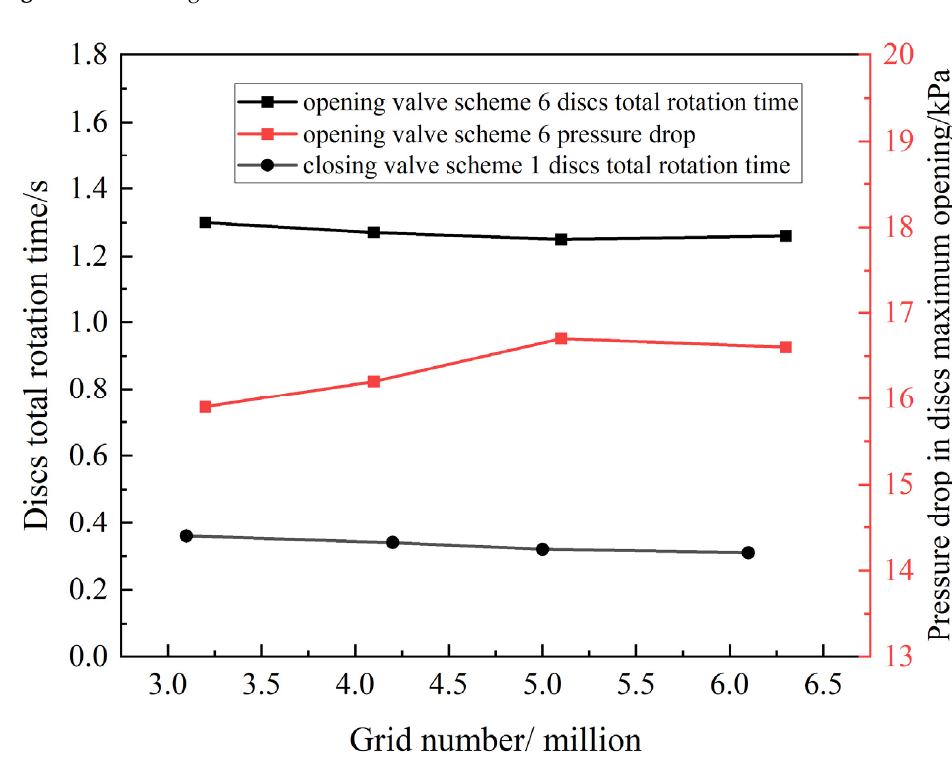
Figure 4. Grid independence.